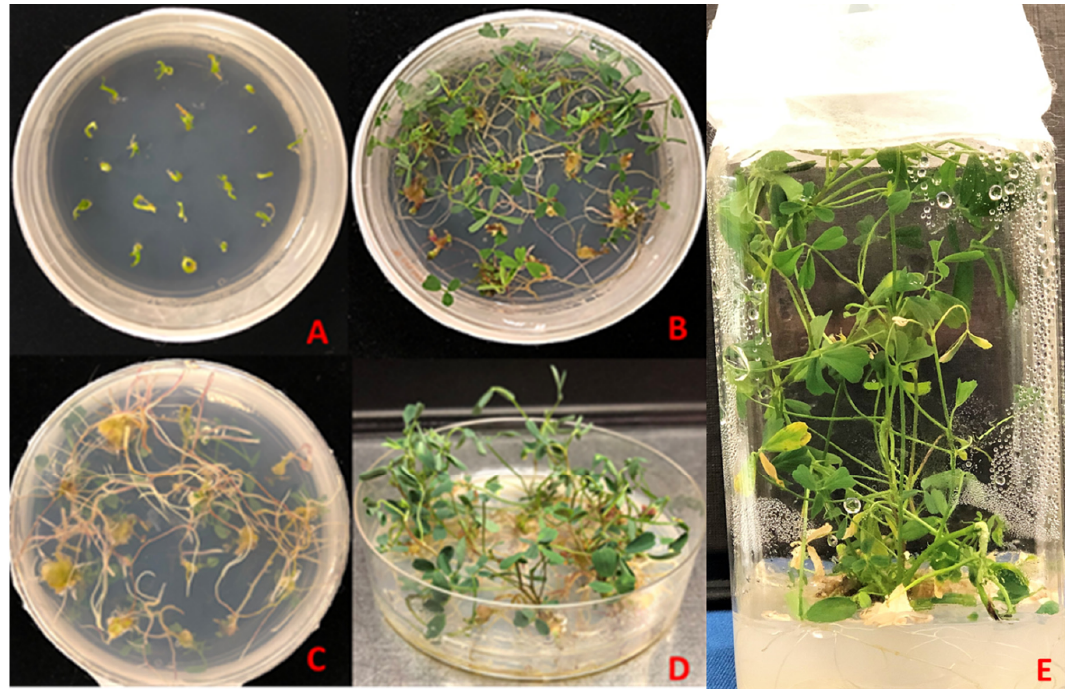
Figure 7. Embryo germination and rooting. ( A ) Mature embryos picked and germinated separately, ( B ) embryos forming plantlets after germination, ( C ) root formation after somatic embryo germination, ( D ) plantlets ready to be transferred and ( E ) an in vitro plant produced from somatic embryo.